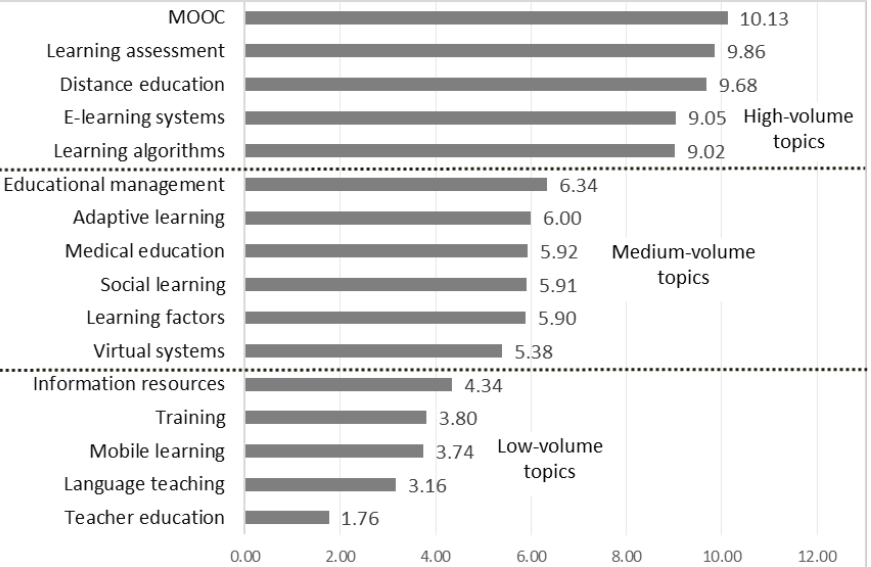
Percentage Rates of Articles From 2000 to 2019 for Each